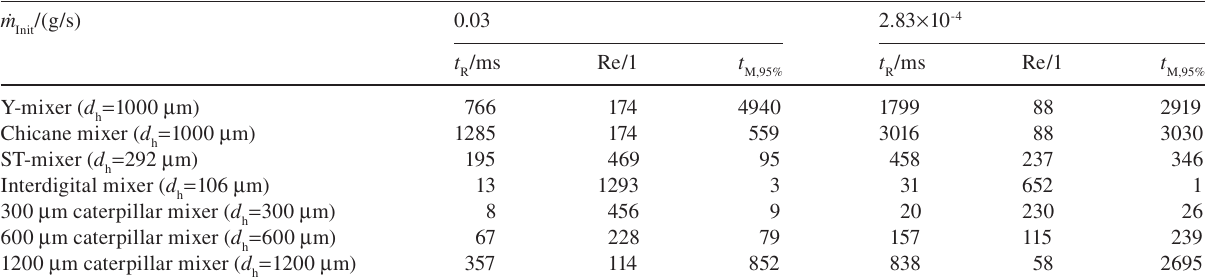
Table 3 Space times, Reynolds numbers and mixing times for all investigated micromixers and highest and lowest initiator fl ow rate. m ˙ /(g/s) Init